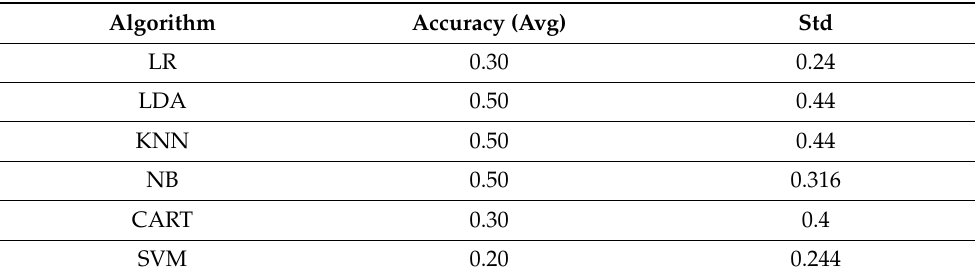
Table 4. Algorithm performance on survey data.